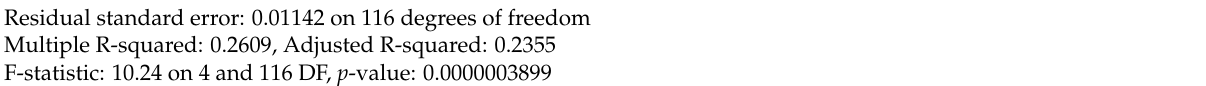
Table 3. Results of multivariate analysis of mean evening personal best peak expiratory flow rate.